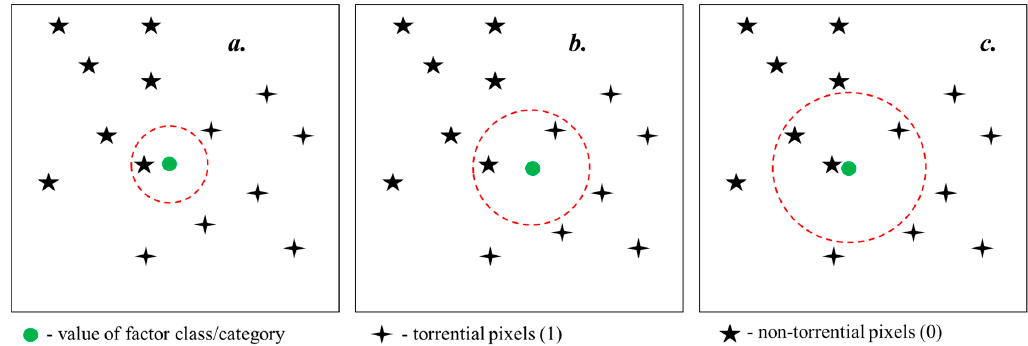
Figure 5. Examples of the different number of nearest neighbors used in a k ‐ Nearest Neighbor (kNN) model: ( a ) 1 ‐ nearest neighbor; ( b ) 2 ‐ nearest neighbors; ( c ) 3 ‐ nearest neighbors.